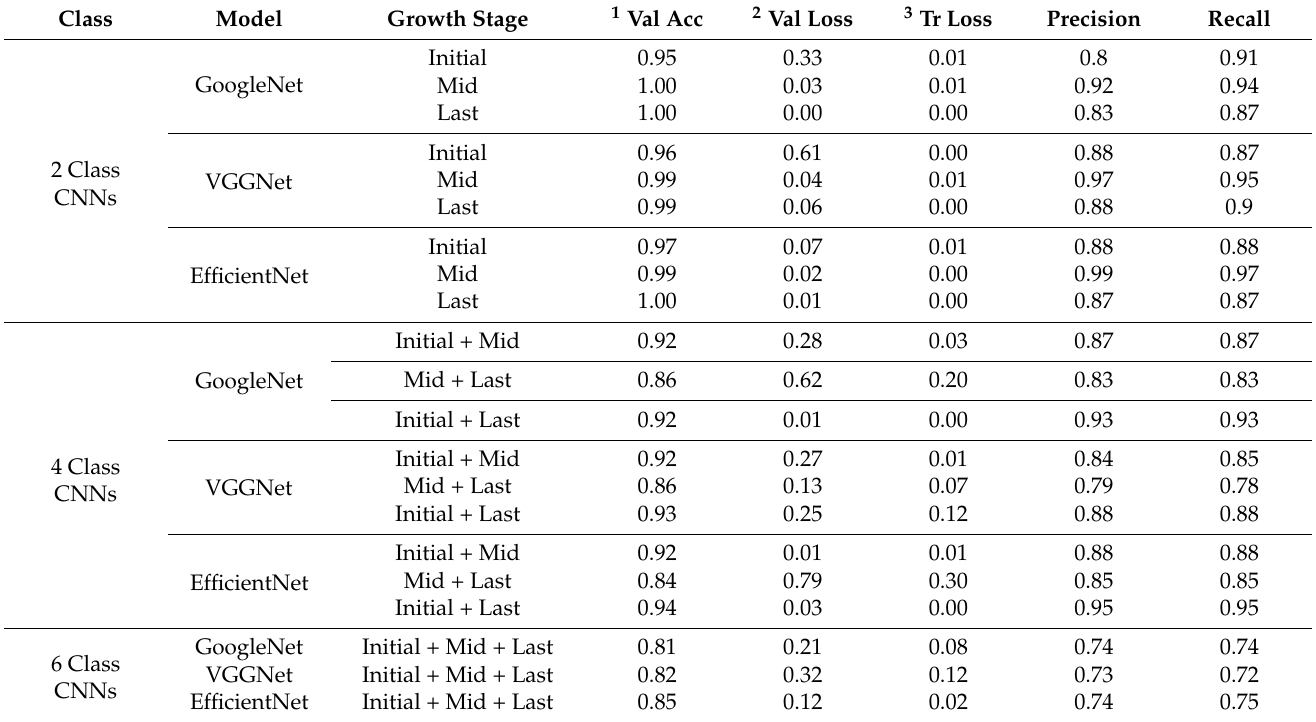
Table 2. Training and statistical evaluation of the 2-, 4- and 6-Class convolutional neural networks in classifying the early blight disease stages for the potato production